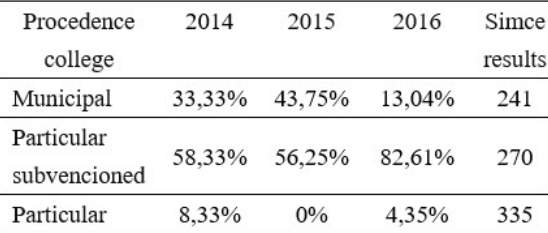
Table 2. Procedence college in some generations and Simce